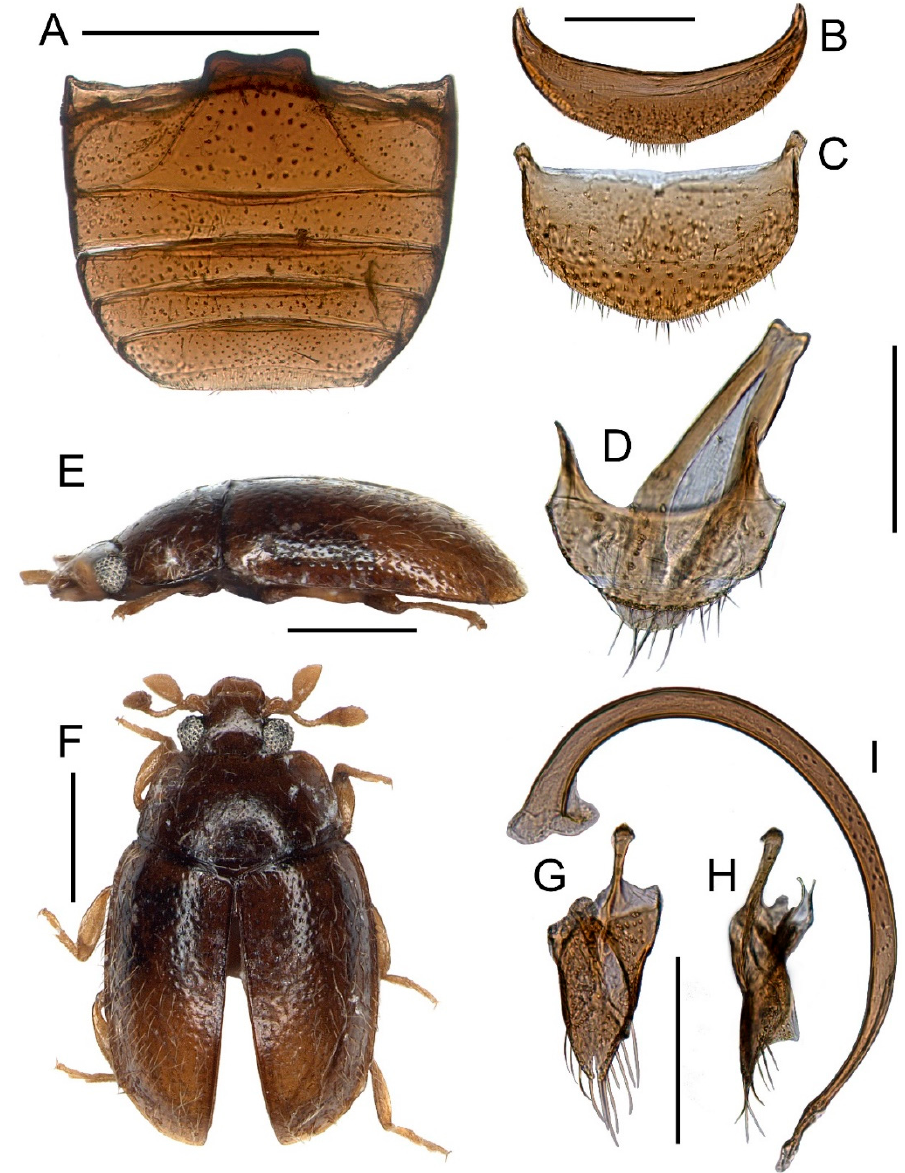
Figure 2. Morphology of Madeirodula atlantica gen. et sp. nov. ( A ) abdomen. ( B ) ventrite 6 (sternite VIII). ( C ) tergite VIII. ( D ) male abdominal segments IX and X. ( E ) habitus, lateral. ( F ) habitus, dorsal. ( G ) tegmen, inner. ( H ) tegmen, lateral. ( I ) penis, lateral. Scale bars: 0.5 mm ( A , E , F ); 0.2 mm ( B – D , G – I ). Type genus. Madeirodula gen. nov., by monotypy and present